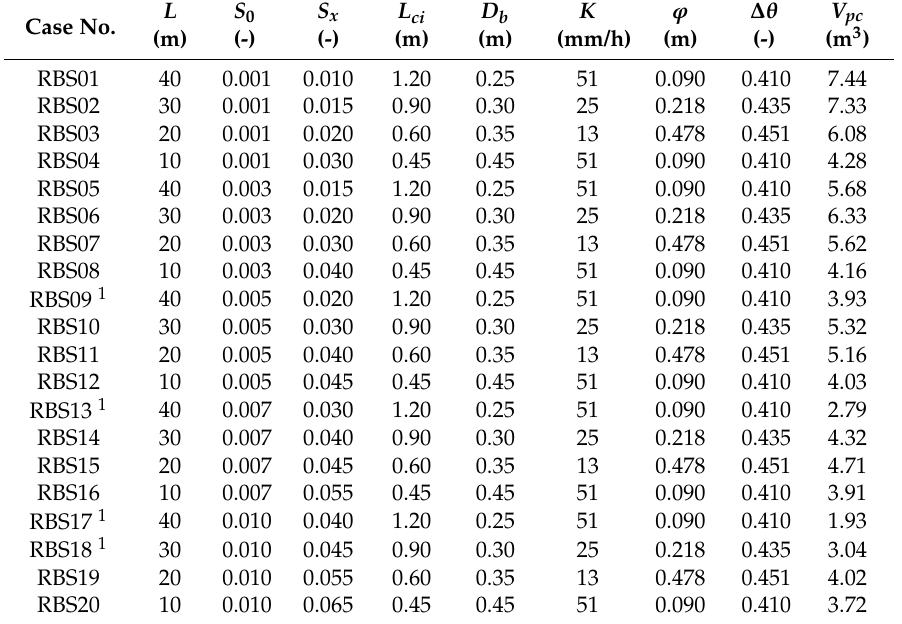
Table 1. Parameter values of 20 modeling cases of the road-bioretention strip (RBS) systems with an undepressed curb inlet and grate inlets (Figure